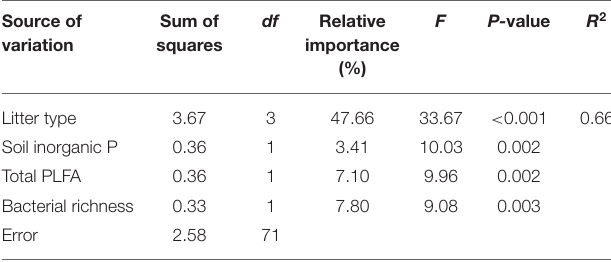
TABLE 3 | Two way ANOVA results for the effects of soil origin, litter type, and an interaction term on litter mass loss (log-transformed) after 31, 105, and 398 days. df Source of variation